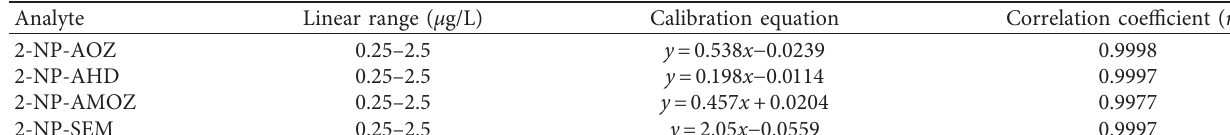
Table 2: Linear range, correlation coefficient, and calibration curves of 2-NP-NFMs.